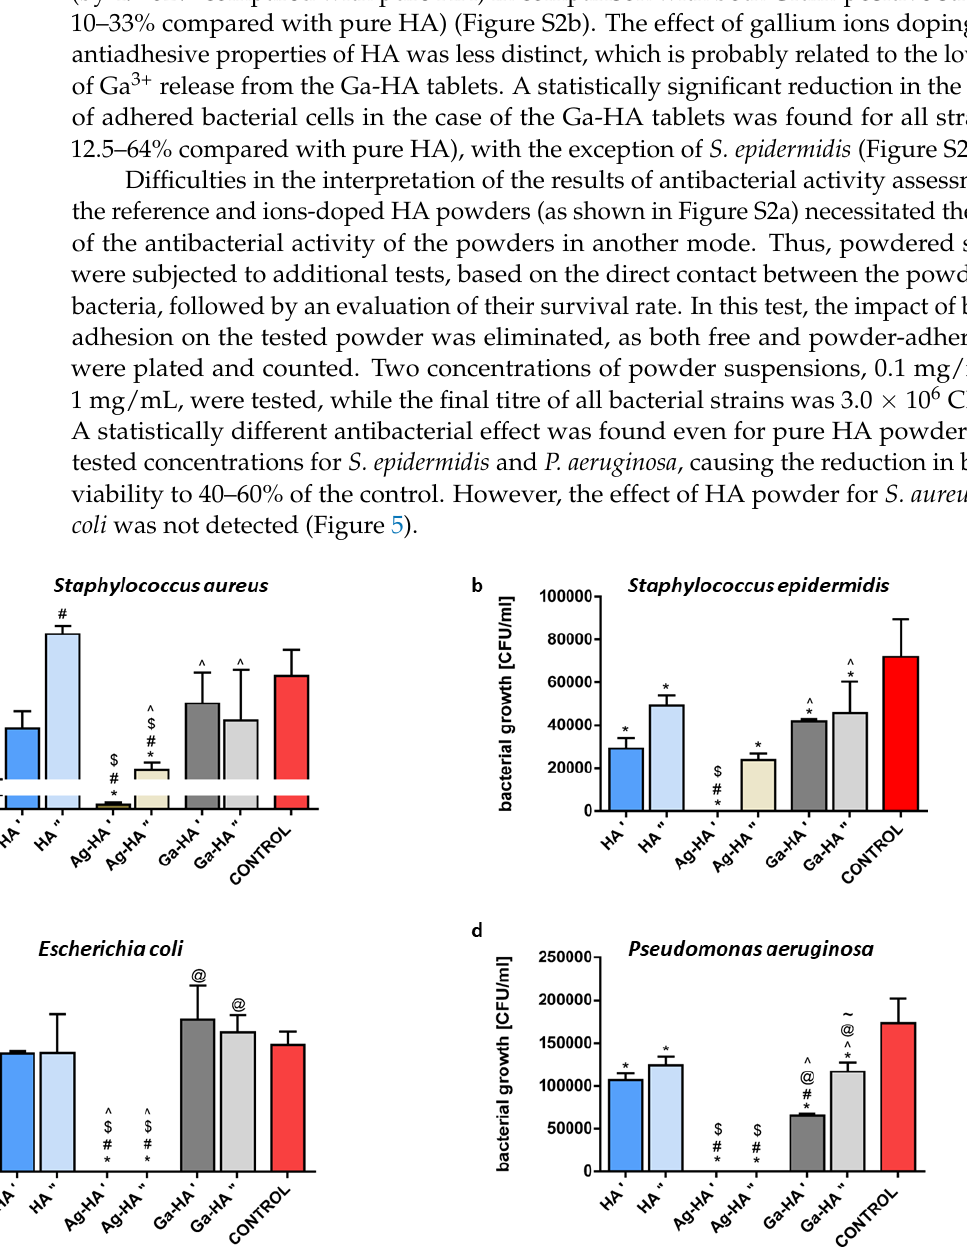
Figure 5. Antibacterial activity of hydroxyapatite powders against 4 bacterial strains: Staphylococcus aureus (a), Staphylococcus epidermidis (b), Escherichia coli (c) and Pseudomonas aeruginosa (d). ( ʹ ) and ( ʺ ) symbols accompanying powders designation on X axes indicate their concentration in mixtures (0.1 mg/mL and 1 mg/mL, respectively). (*) symbol indicates statistically significant differences between the samples and control, (#) symbol indicates statistically significant results between HA ʹ and the samples, ($) symbol indicates statistically signi fi cant results between HA ʺ and the samples, (^) symbol indicates statistically significant results between Ag-HA ʹ and the samples, (@) symbol indicates statistically significant results between Ag-HA ʺ and the samples, (~) symbol indicates statistically significant results between Ga-HA ʹ and the samples; according to one-way ANOVA with post-hoc Dunnett’s test or post-hoc Tukey’s test ( p < 0.05). Although it was recognized that hydroxyapatite was biologically inert and did not act toxically on bacteria, there were some observations indicating the antibacterial activity of nanohydroxyapatite, both artificial (obtained by the wet precipitation method or by the microwave-assisted method) [50,51] and natural source-derived [52]. Our results are, to some extent, confirmation of previous reports. The effect of the Ag-HA powder was the most striking; in the case of all strains, 1 mg/mL of Ag-HA powder reduced the bacterial viability completely or almost completely. The same was observed for the 0.1 mg/mL Ag- HA powder concentration by comparison with both Gram-negative strains, while in the case of the Gram-positive strains, the reduction in bacterial viability reached 25-35% of the